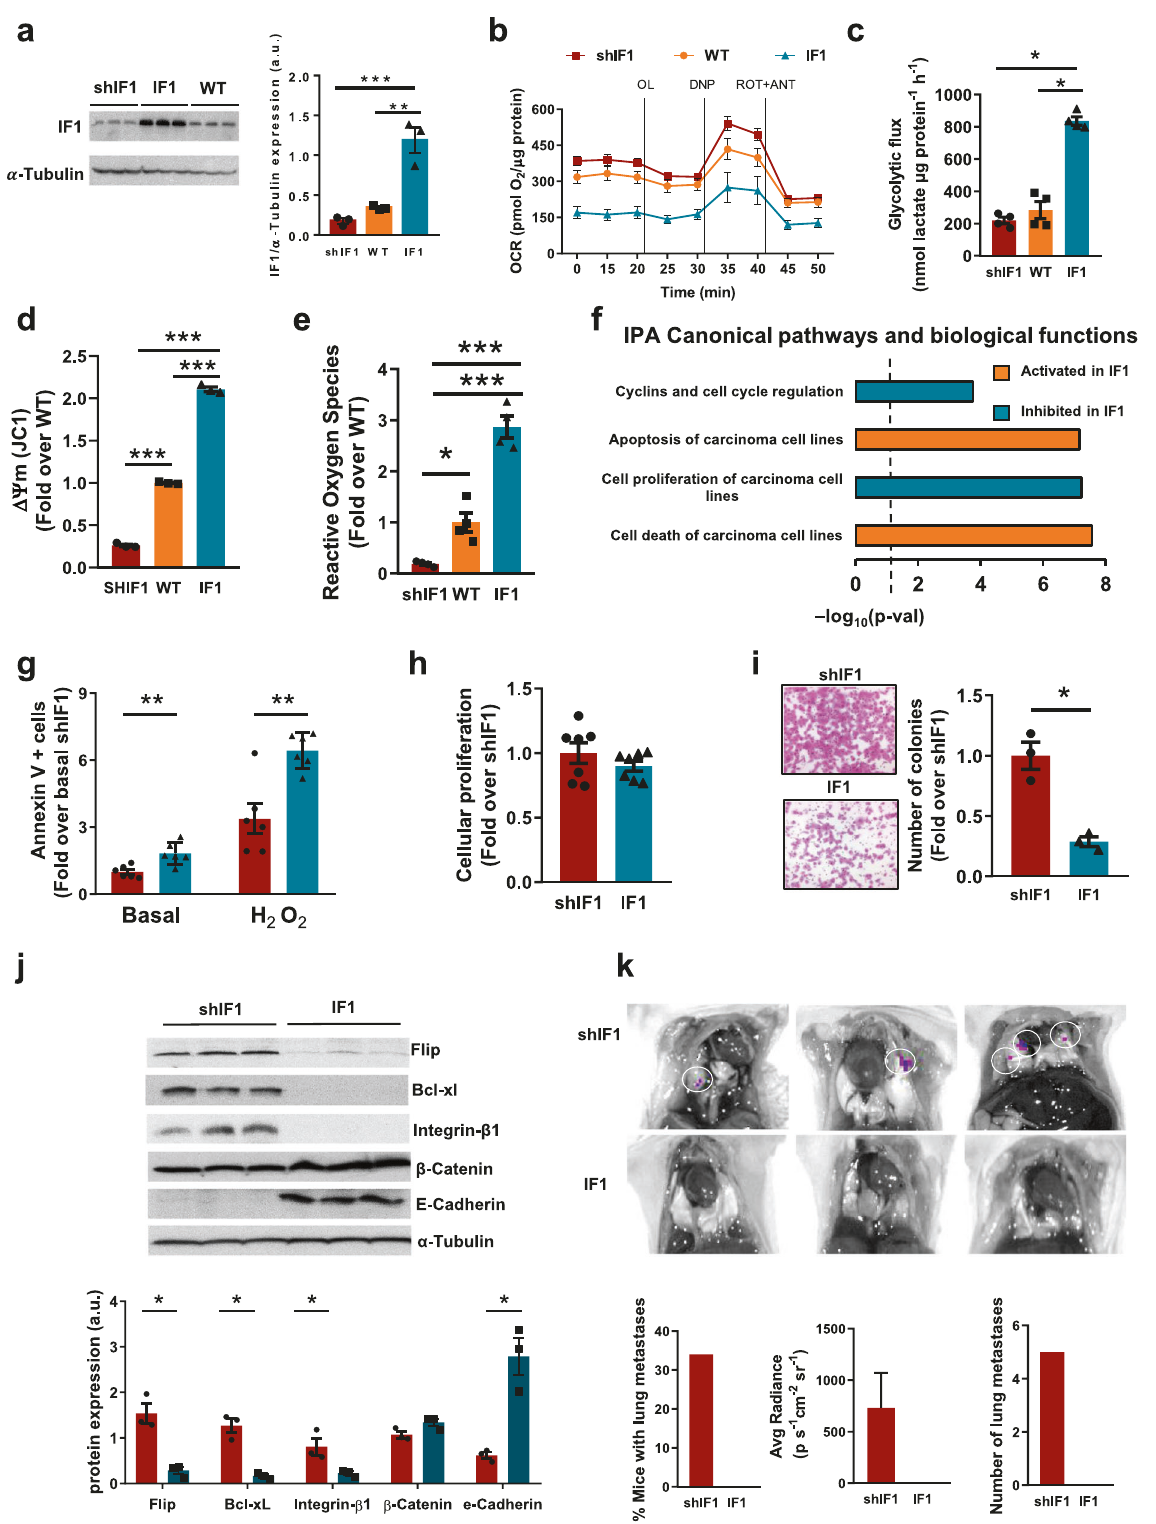
(SOD2, PRX3) also compromise the survival of LUAD patients (Fig. 7). On the contrary, the upregulation of enzymes that feed carbon skeletons for mitochondrial oxidation (CPT1, HADHA, ETFA), mitochondrial structure (HSP60) or the cytoplasmic antioxidant response (PRX6) are favorable biomarkers of